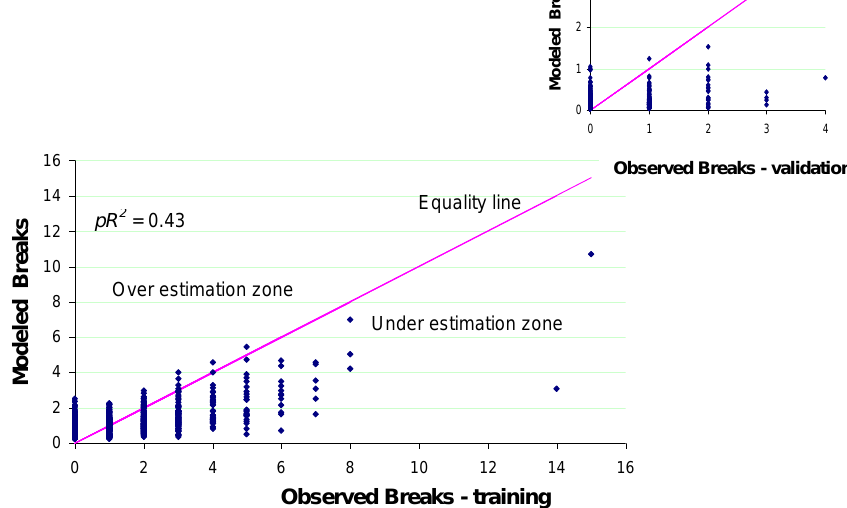
Figure 2 . Training and validation results.